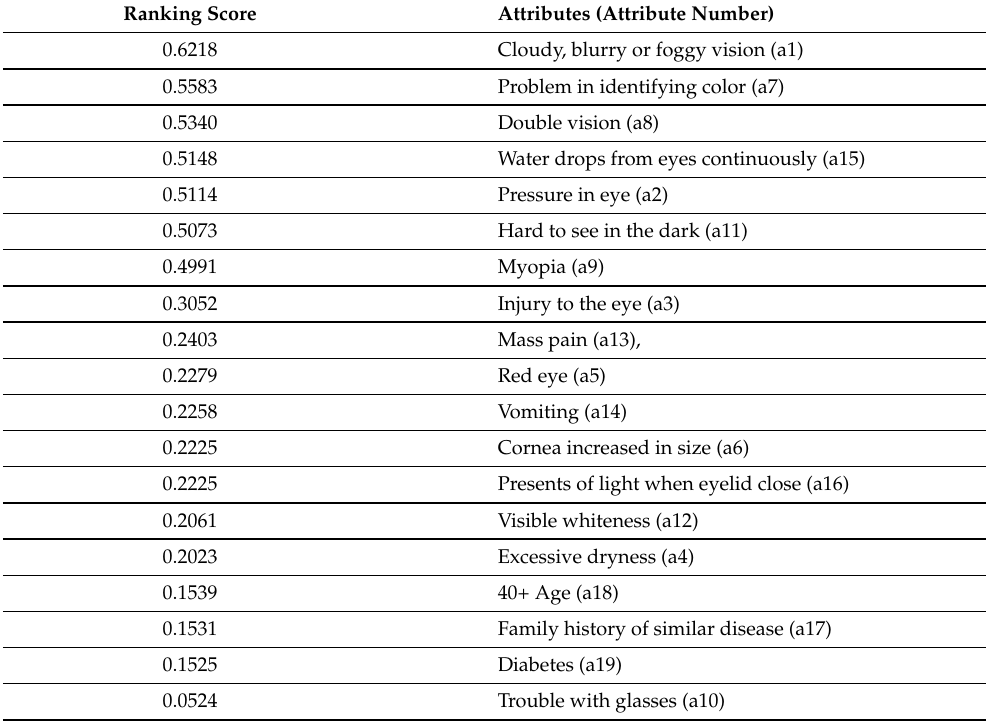
Table 3. Ranking of Features and associated correlation coefficient values from PC-based FS